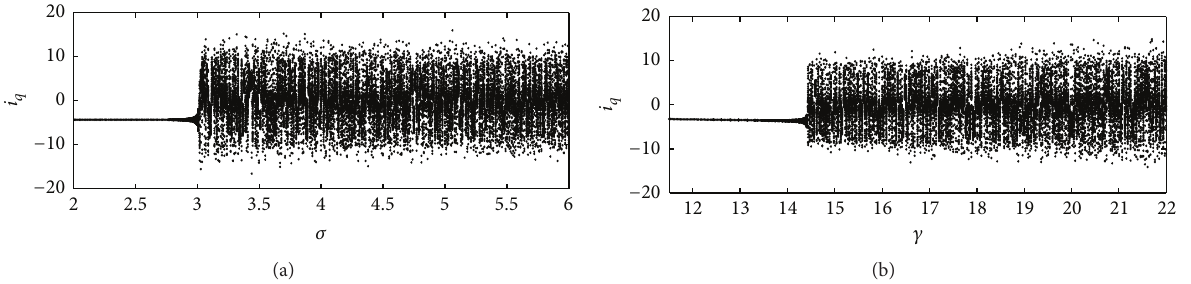
Figure 2: Bifurcation diagrams of 𝑖 𝑞 versus (a) 𝜎 with 𝛾 = 20 and (b) 𝛾 with 𝜎 = 5.45